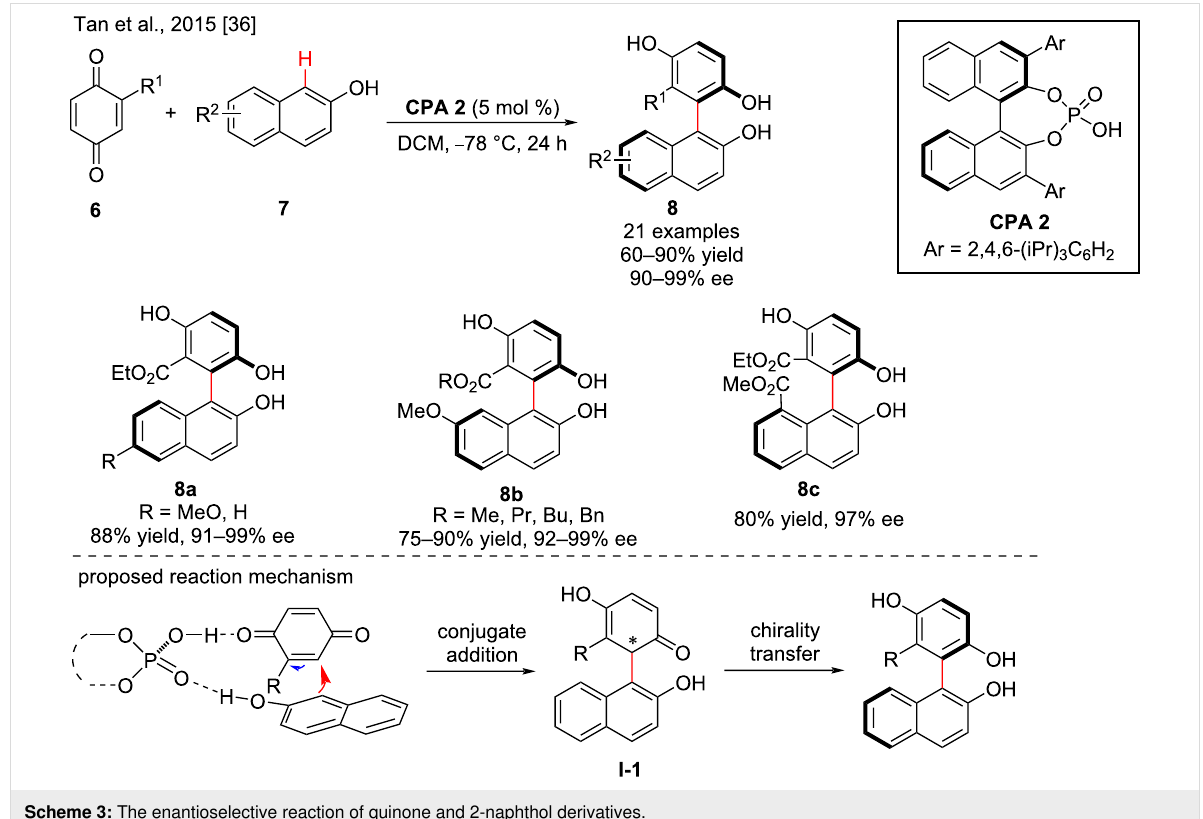
Scheme 3: The enantioselective reaction of quinone and 2-naphthol derivatives.